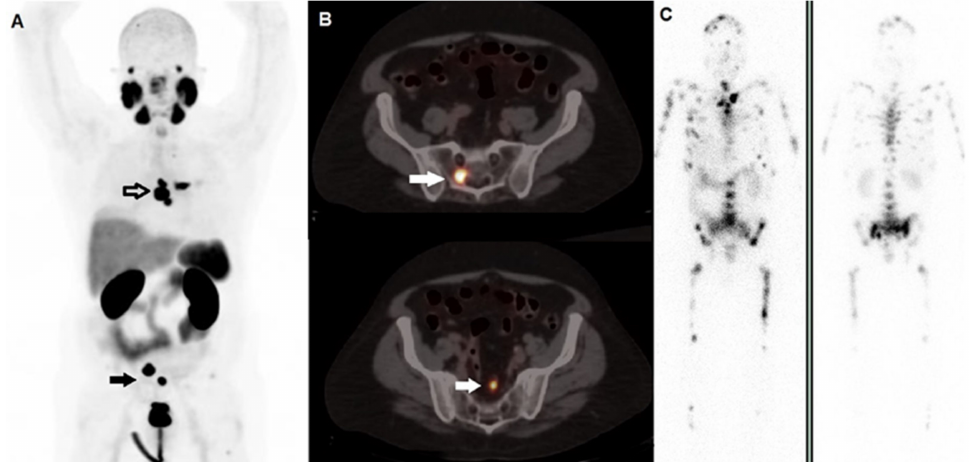
Figure 1. A 59-year-old man affected by prostate cancer, diagnosed in 2016 and submitted to prostatectomy (Gleason score 4 + 5, ISUP 5, pT3b pN1), subsequently treated with adjuvant androgen deprivation therapy. After 2 years, progressively increasing values of PSA were registered, and the patient underwent 2nd generation anti-androgen therapy with abiraterone and, due to progressive skeletal disease, chemotherapy with taxanes. ( A ) Whole Body 68 Ga-PSMA-11 PET/CT demonstrated highly increased tracer incorporation within metastases in the thorax (black bordered arrow) and pelvis (black arrow). ( B ) Fused PET/CT axial images well depicted PSMA-avid lesions in sacrum (upper row, white arrow) and in a pelvic node (lower row, white arrow). Two months later, he underwent radioligand therapy with 177 Lu-PSMA-617; PSMA PET/CT was not repeated due to the shortage of tracer’s availability. ( C ) Whole planar images (left side; anterior view, right side: posterior view) carried out by scintigraphy on 177 Lu’s photopeaks after the 1st cycle of 177 Lu-PSMA-617 showed multiple sites of tracer incorporation with a much more extensive skeletal metastatization than that revealed by PET/CT. This discrepancy might be explained by the too long interval of time occurred between the diagnostic phase and the therapeutic procedure in a subject with rapidly progressive